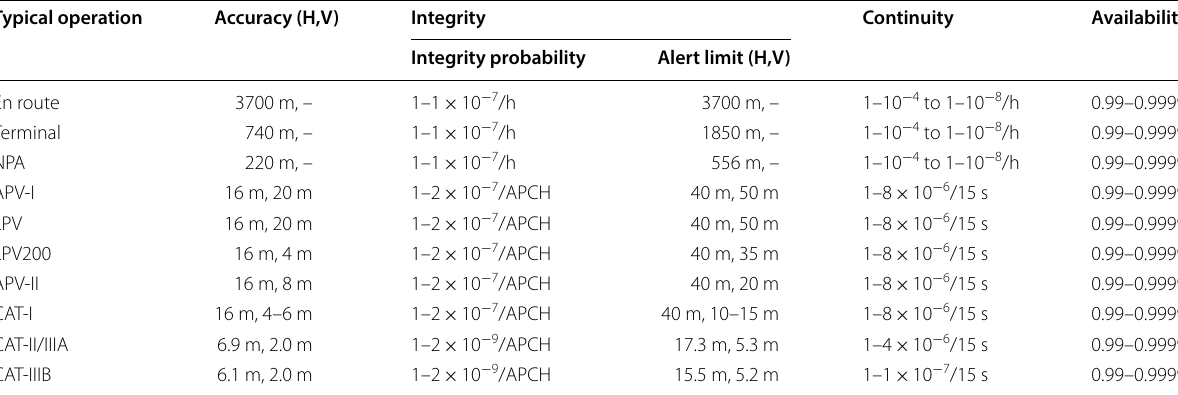
APCH APproaCH, H Horizontal, V Vertical